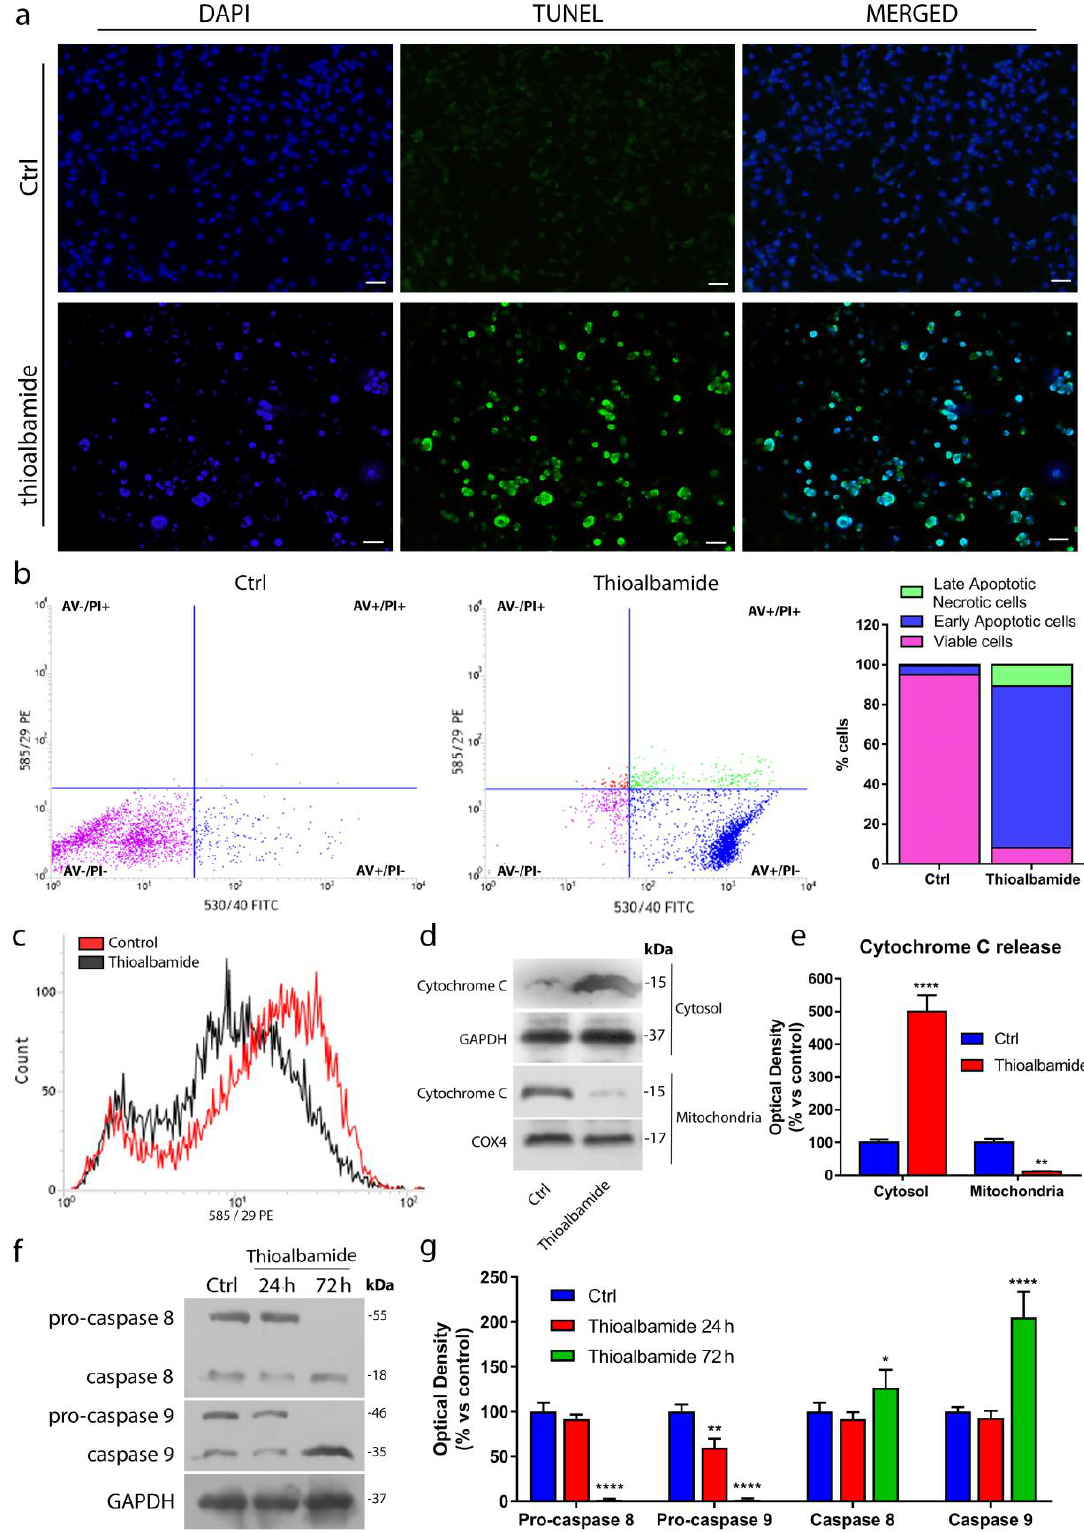
Figure 4. Thioalbamide induces cell death by activation of both extrinsic and intrinsic apoptotic pathways. ( a ) TdT-mediated dUTP nick-end-labeling (TUNEL) assay in MCF7 cells treated for 72 h with vehicle (Ctrl) or thioalbamide. DAPI was used for DNA staining (scale bar: 50 μm). ( b ) Annexin V-PI assay was performed to detect apoptosis in DMSO-treated cells (Ctrl) and cells treated with thioalbamide for 24 h; histograms represent the percentage of cell populations after treatment. ( c ) Loss